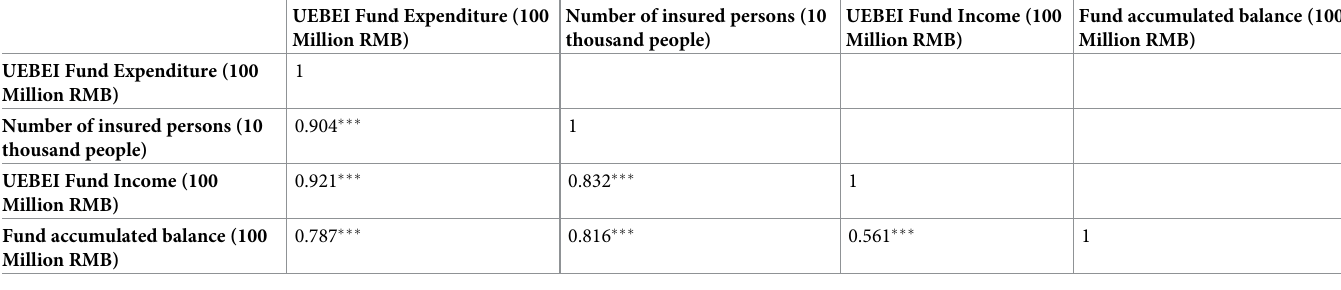
Table 2. Correlation analysis of input index and output